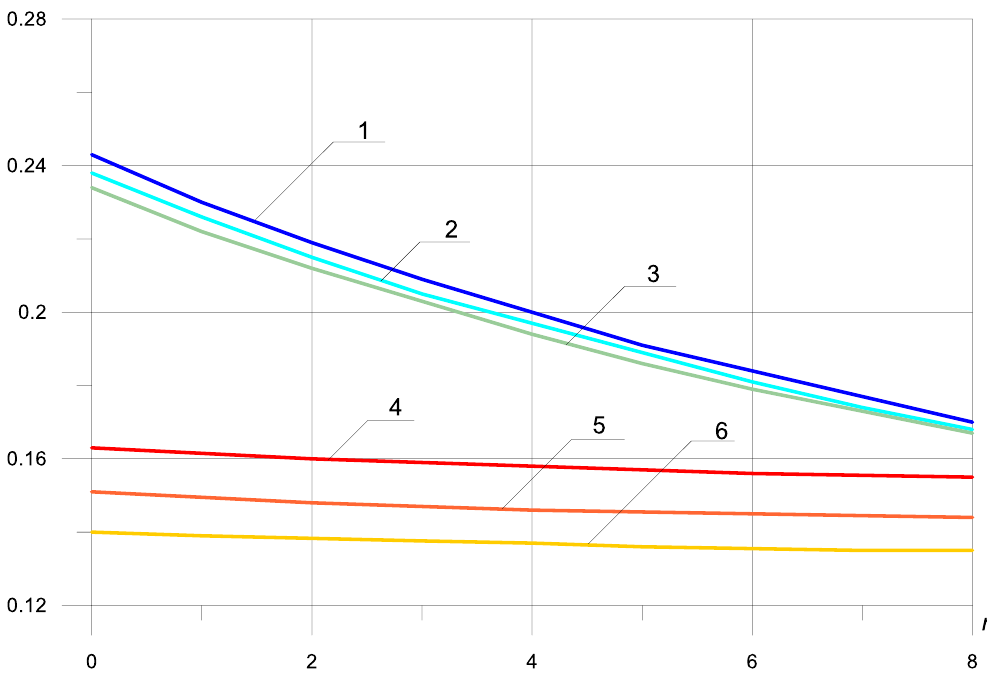
Figure 5. Dynamic stresses with bimodularity depending on the number of bars in the zone under tension, taking into account the beam mass: (1) σ t at n c = 0; (2) σ t at n c = 2; (3) σ t at n c = 4; (4) σ c at n c = 0; (5) σ c at n c = 2; (6) σ c at n c = 4.